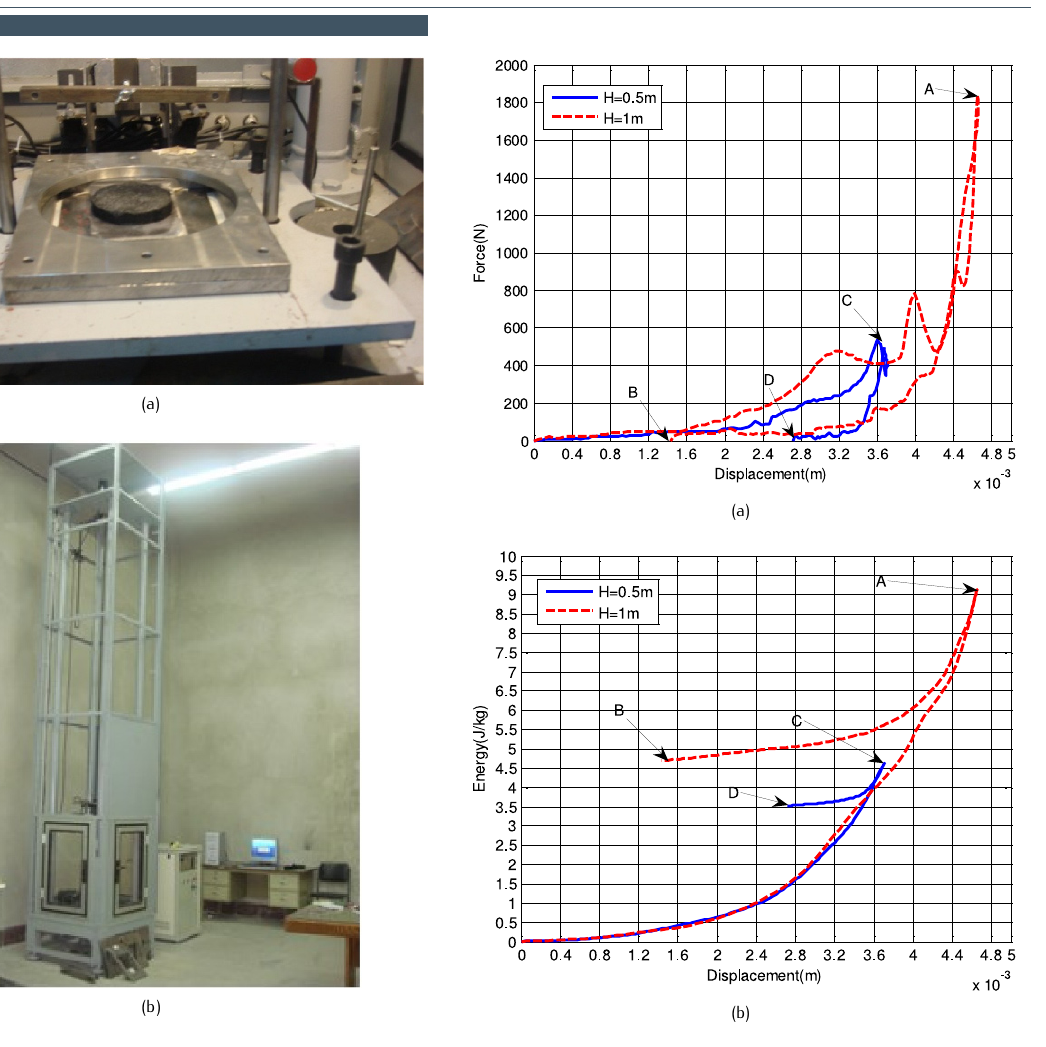
Figure 10. Elastomeric EPDM foam in two drop height (a) contact force versus displacement; (b) absorbing energy versus